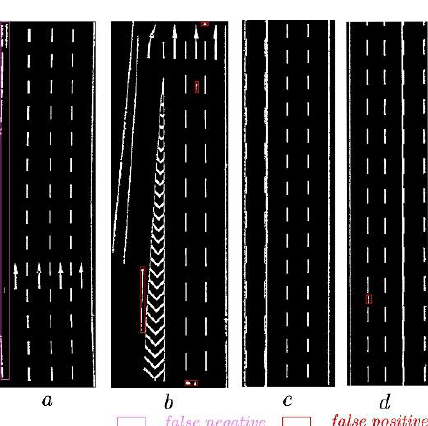
Figure 13. Raster image